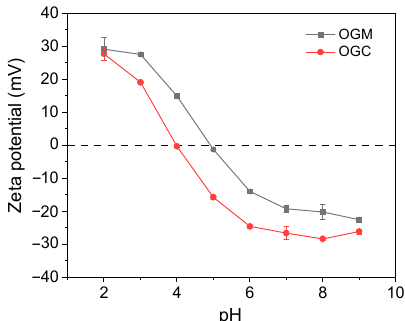
Figure 4. Zeta potential of OGM and OGC heated for 96 h.